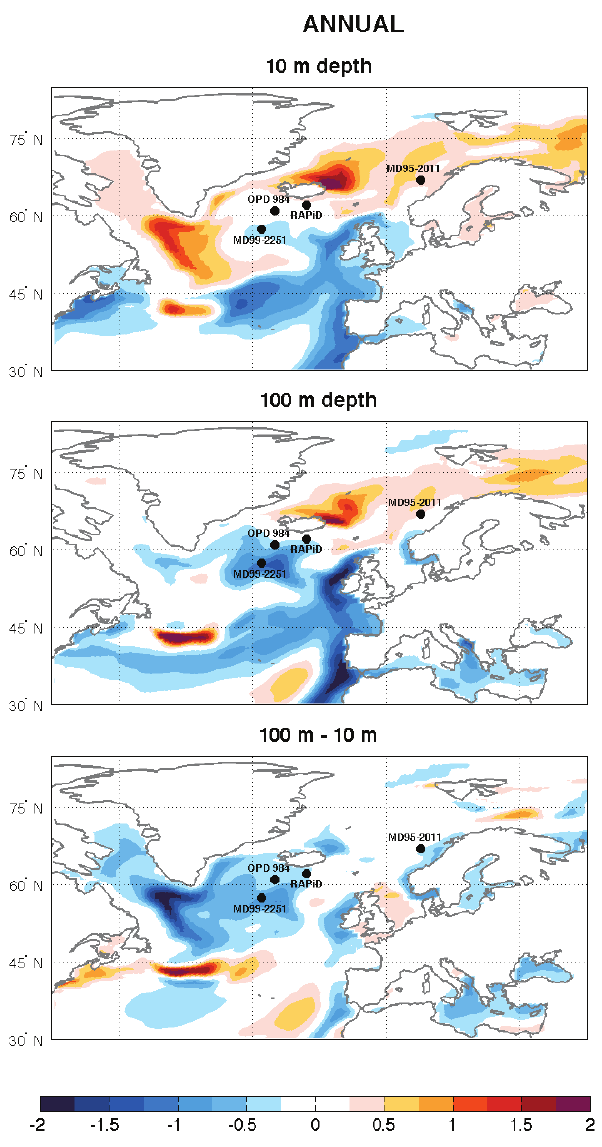
Fig. 11. 6k-0k CCSM3 model result for the annual mean tempera- ture for 10m and 100m as well as the 6k-0k anomaly for the differ- ence between 100m and